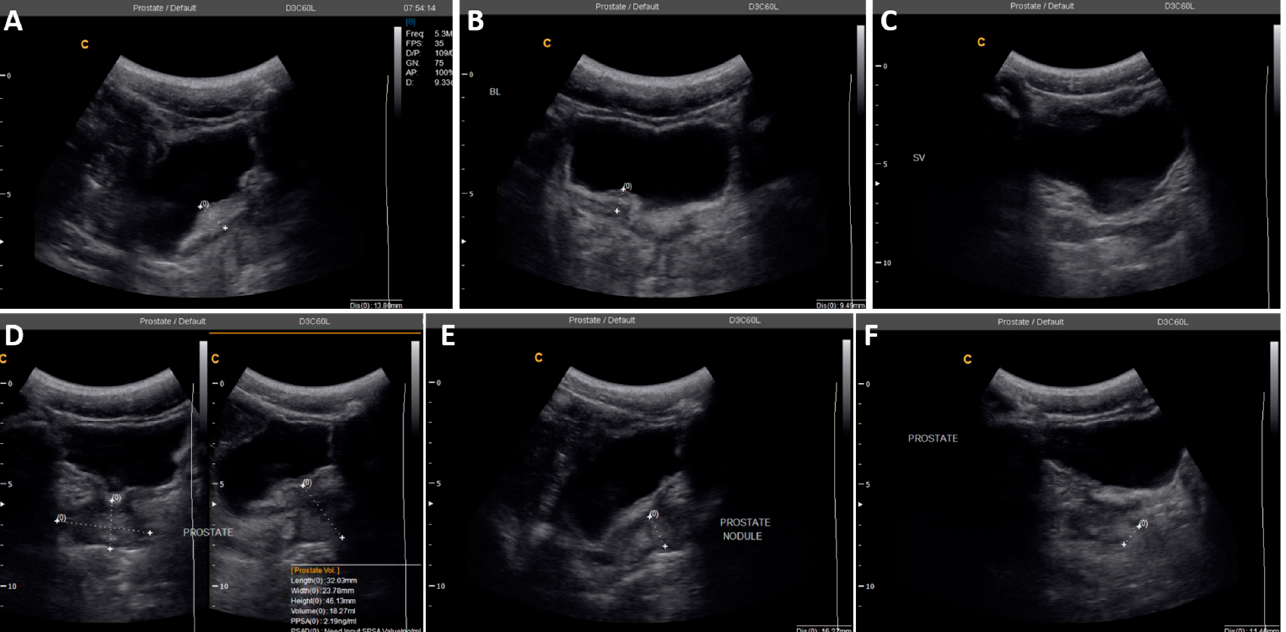
Figure 3. Ultrasonographic images of an MGS positive study participant with abnormalities in the bladder and prostate at Baseline. ( A , B ). Irregular urinary bladder wall and severe focal thickness, measuring up to 13.6 mm. ( C ). Normal symmetrical seminal vesicles. ( D ). Prostate with abnormal irregular outline, but normal volume of 18.3 mL. ( E , F ). Hyperechoic nodule in the prostate, measuring 11.4 mm by 16.2 mm.